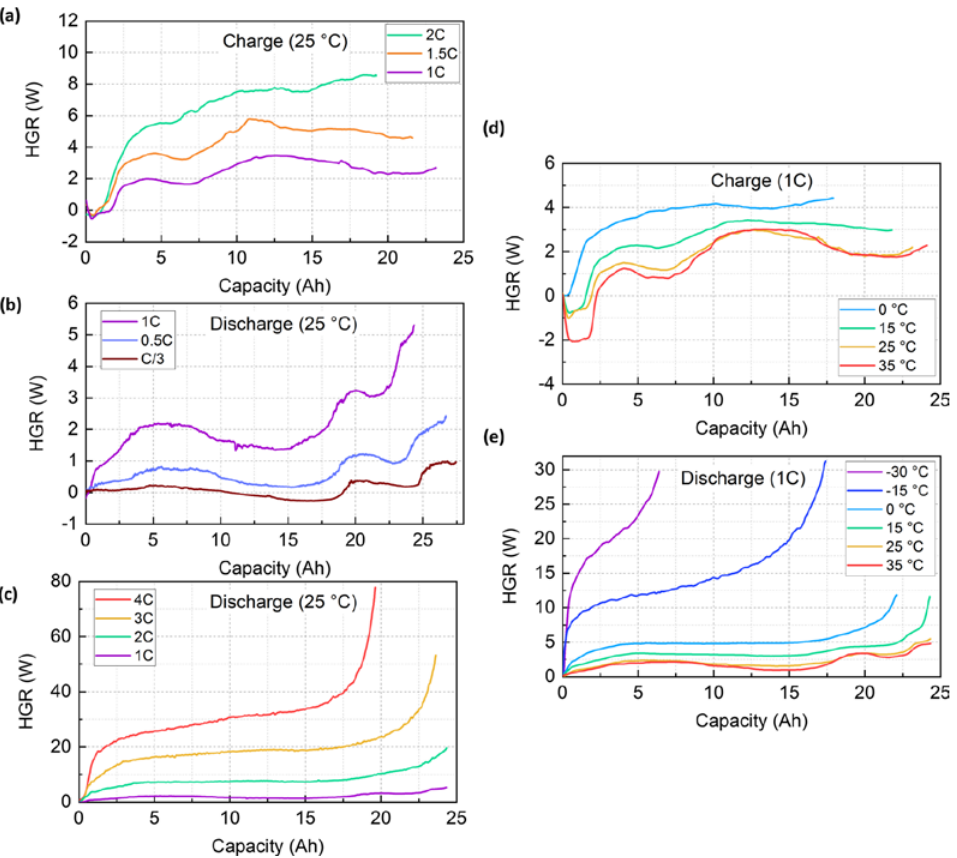
Figure 3. Measurement results of heat generation rates at different C rates during ( a ) charging rates of 1 C, 1.5 C, and 2 C at T amb 25 ◦ C; ( b ) discharging rates of C/3, 0.5 C, and 1 C at T amb 25 ◦ C; ( c ) discharging rates of 1 C, 2 C, 3 C, and 4 C at T amb 25 ◦ C; ( d ) charging rate of 1 C at T ambs of 0 ◦ C, 15 ◦ C, 25 ◦ C, and 35 ◦ C; and ( e ) discharging rate of 1 C at T ambs of − 30 ◦ C, − 15 ◦ C, 0 ◦ C, 15 ◦ C, 25 ◦ C, and 35 (from Hu et al. [6], with permission from Elsevier).